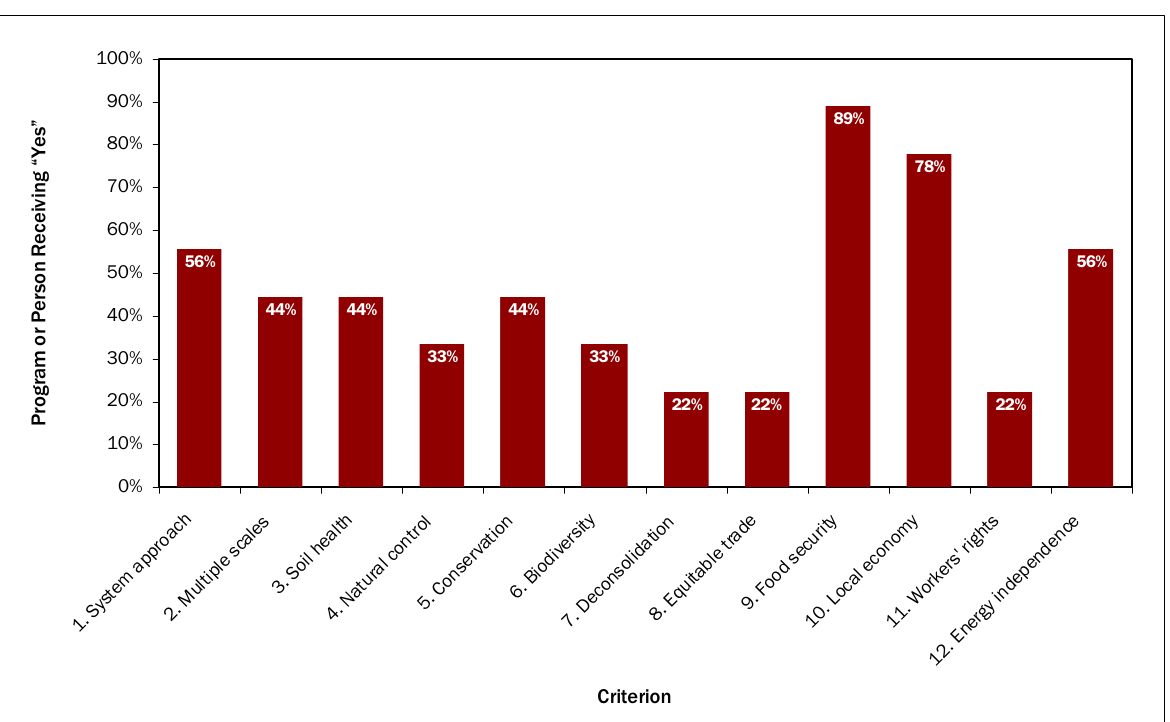
Figure 1. Obama Administration Performance on Movement